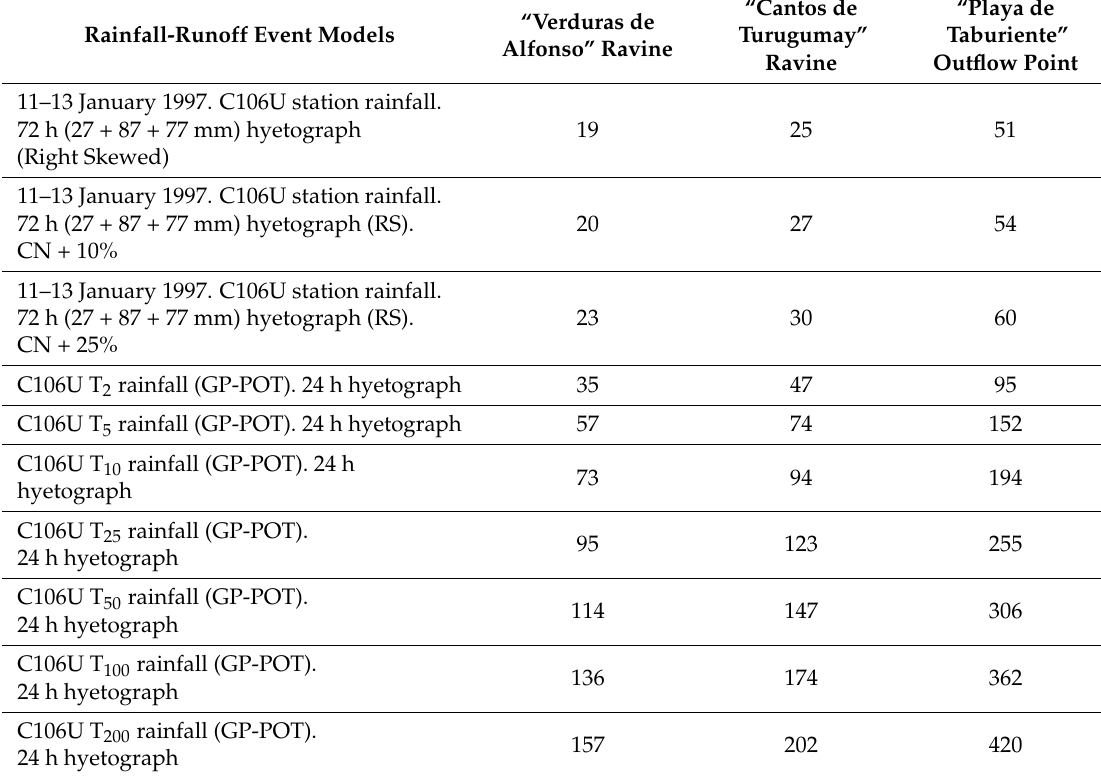
Table 3. Rainfall-runoff model (HEC-HMS) peak flows (m 3 s − 1 ) at Taburiente fluvial basin location points. Rainfall-Runoff Event Models